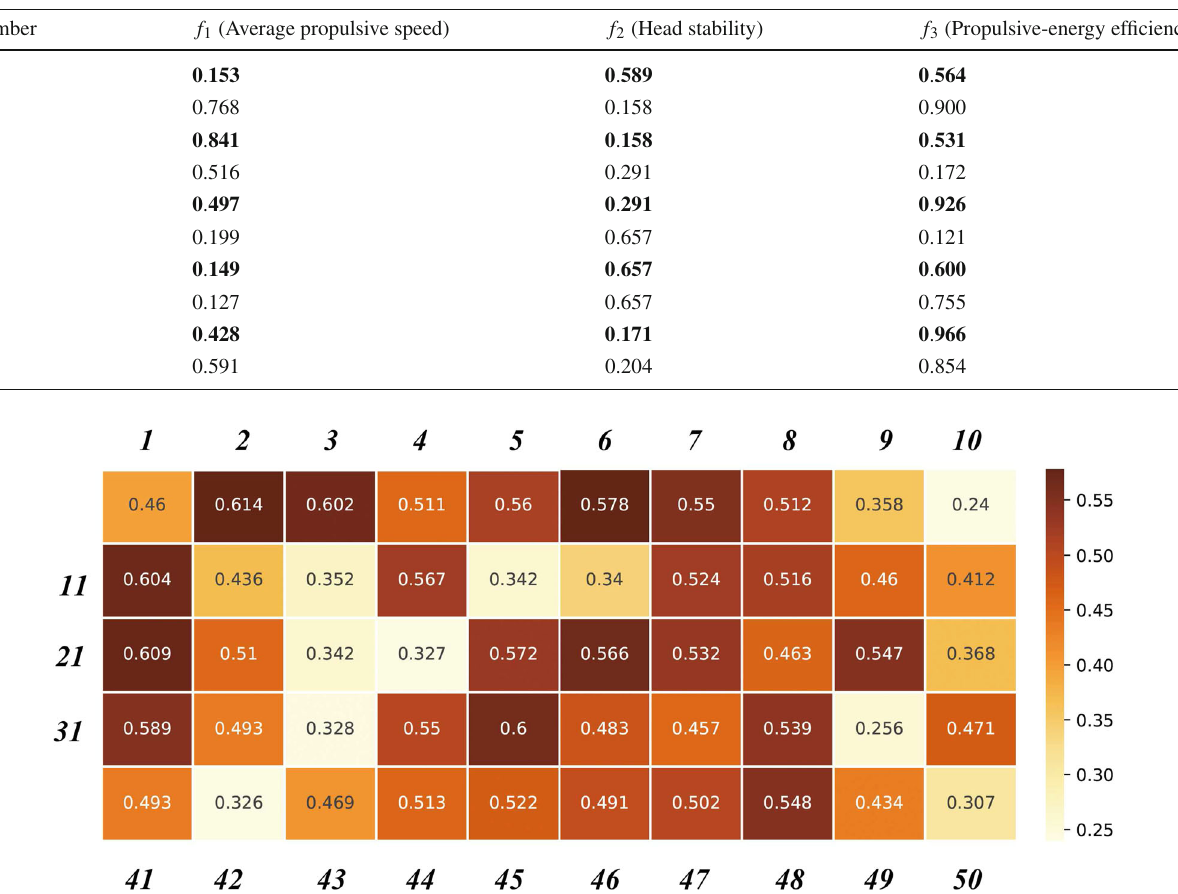
Fig.9 The heat map graph of fifty solutions with three objectives which are transformed from fifty non-dominated solutions using the membership function Table 5 Ten selected solutions with three objective which are transformed from non-dominated solution solutions using membership function